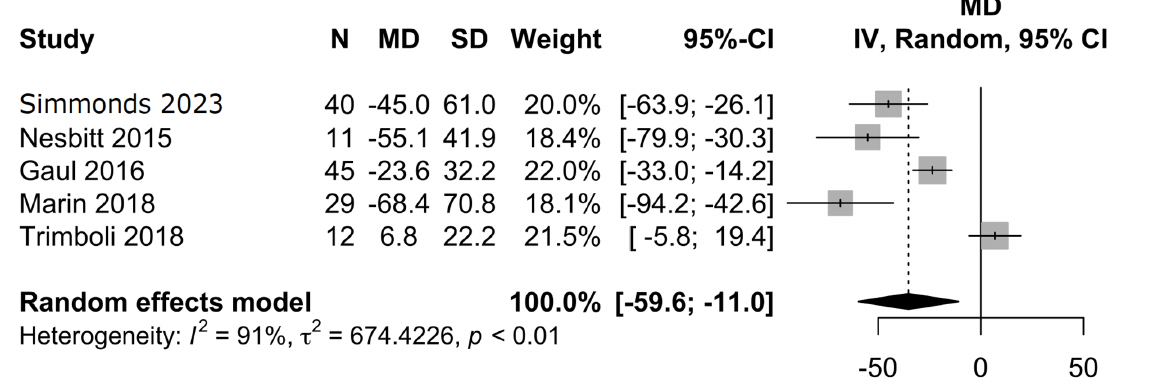
FIGURE 3 Meta-analysis of mean difference in monthly headache attack frequency between baseline and final follow-up.